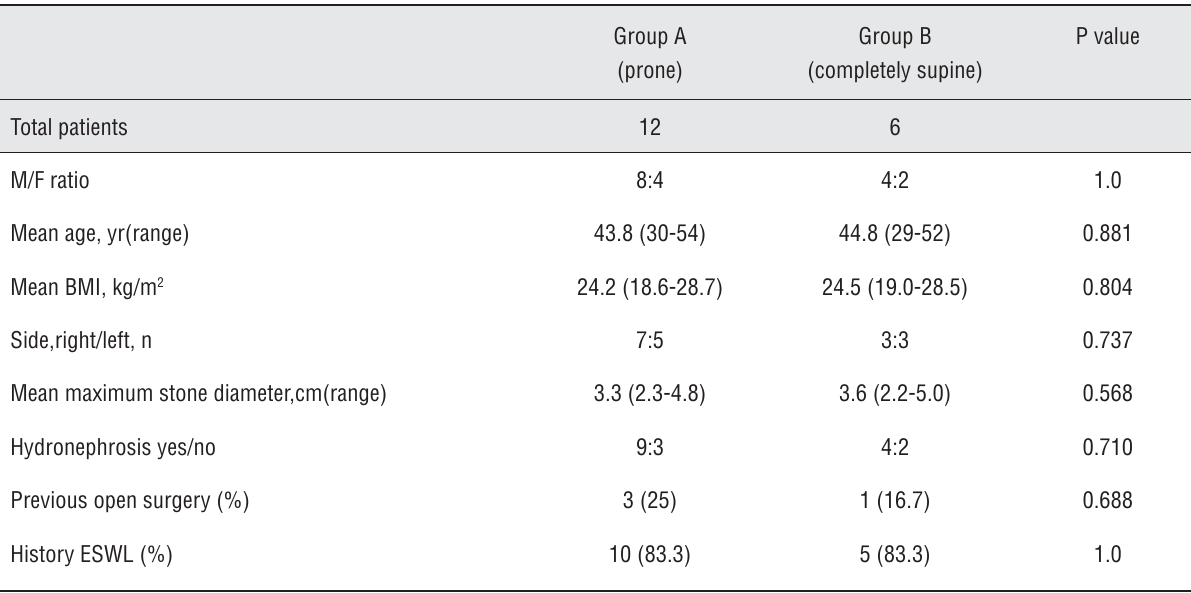
Table 1 - Patient